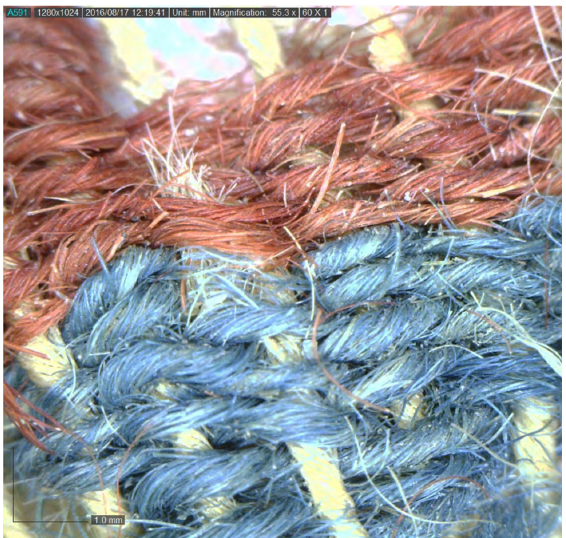
Figure 6 Blue and scarlet textile from Timna‘ 34 (Sukenik et al. 2017,